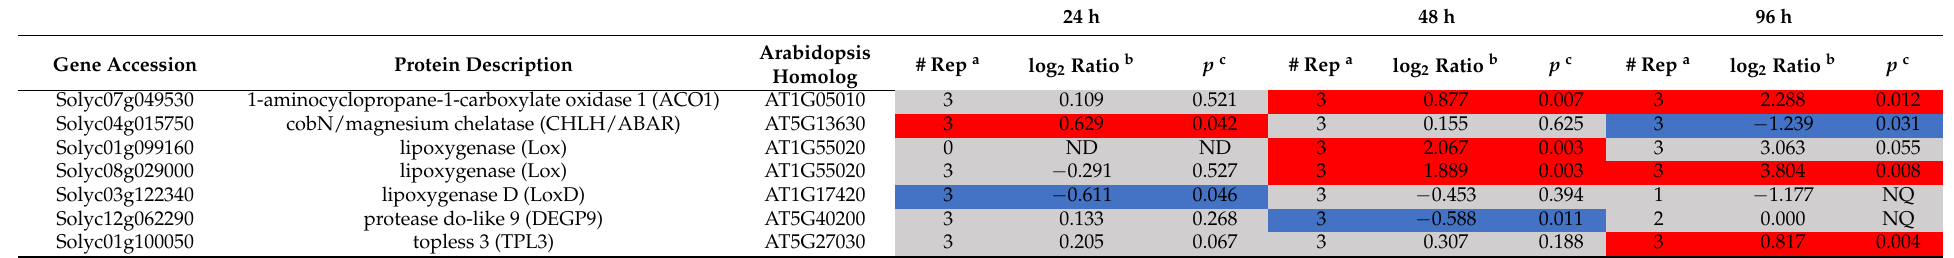
Table 3. Proteins involved in hormone biosynthesis and signaling with significant changes in abundance at 24, 48 and 96 h post-inoculation with P. infestans .